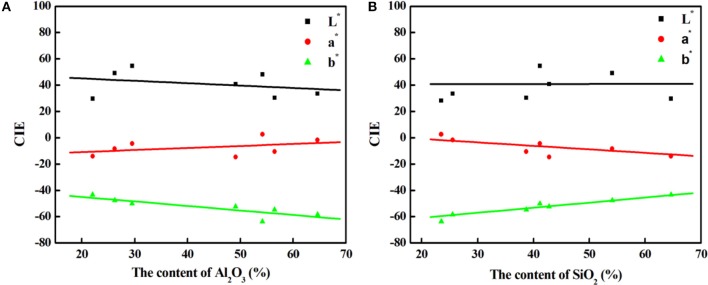
The relationship between the CIE parameters of CoAl2O4 hybrid pigments and the content of Al2O3
(A) and SiO2
(B) of different clay minerals, respectively.